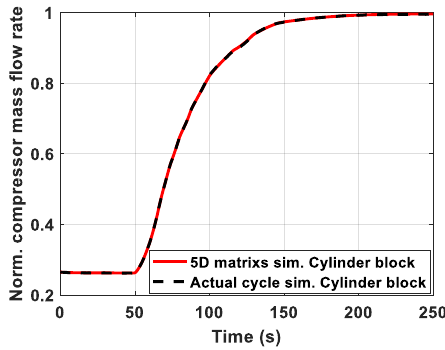
Figure 11. Compressor air flow rate time history.